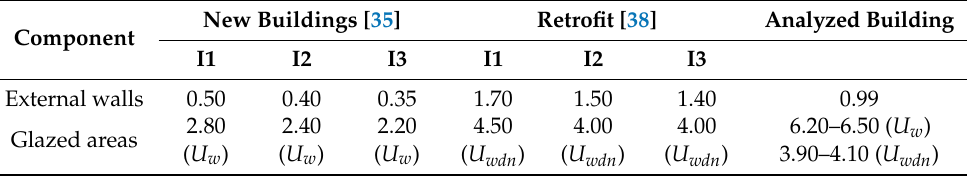
Table 3. Assessment resorting to SCE (Energy Performance Certification System) regarding building envelope